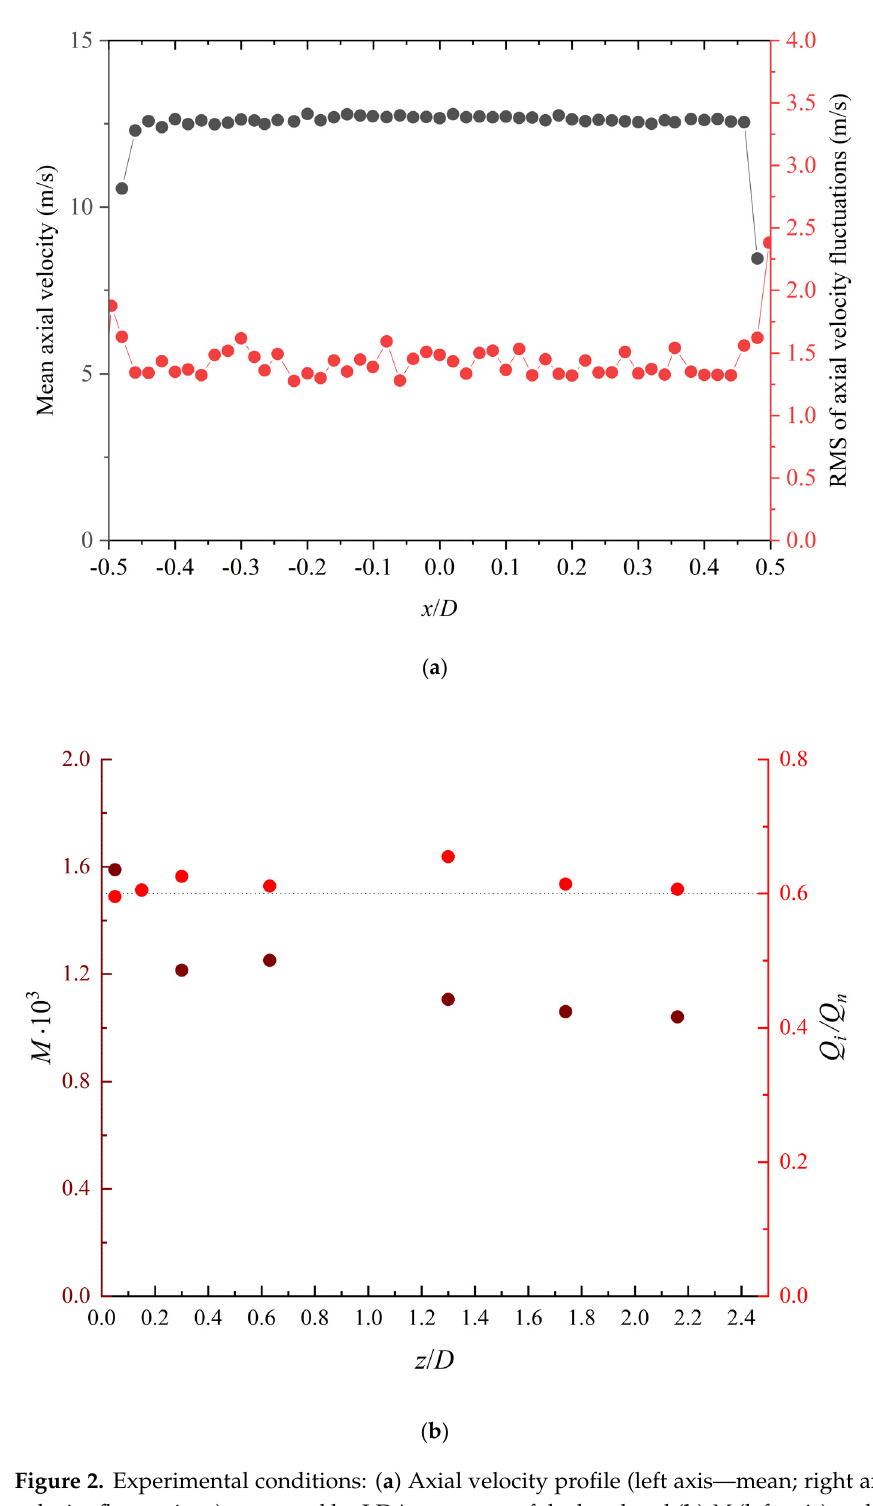
Figure 2. Experimental conditions: ( a ) Axial velocity profile (left axis—mean; right axis—RMS of velocity fluctuations) measured by LDA upstream of the bend and ( b ) M (left axis) and Q i /Q n (right axis) conservation as function of z/D .